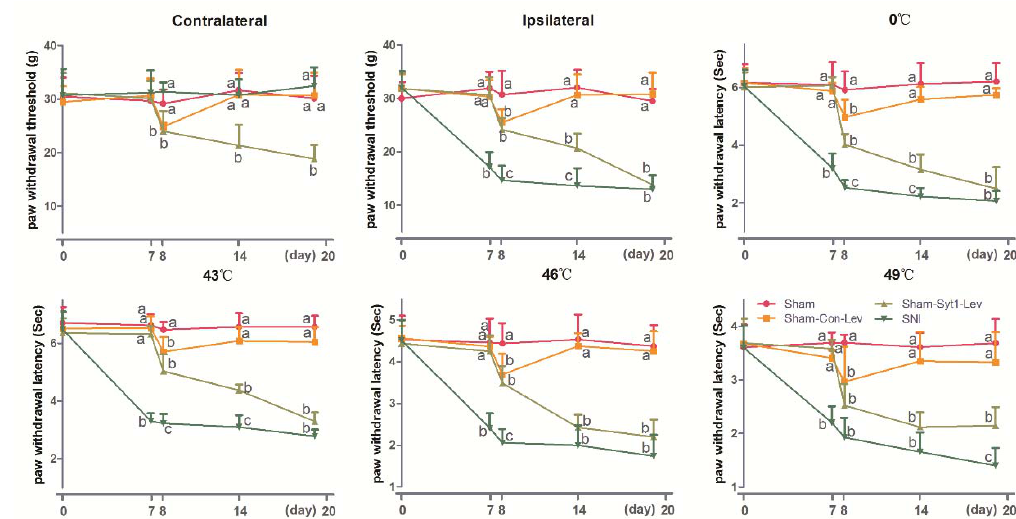
Figure 5. The e ff ect of Syt-1 lentiviral activation particles on PWTs and PWLs (Mean ± SD, n = 6). Rats in Sham-Con-Lev and Sham-Syt1-Lev groups were intrathecally injected with 15 µ L control lentiviral particles and Syt-1 lentiviral activation particles, respectively. Bilateral PWTs and PWLs (0, 43, 46 and 49 ◦ C) in Sham-Syt1-Lev rats were less than those in Sham-Con-Lev at day 14 and 20. Ipsilateral PWTs and PWLs (0, 43, and 46 ◦ C) of Sham-Syt1-Lev rats were decreased during the experiment, but not di ff erent from those of SNI rats at day 20. Values with di ff erent letters (a, b, and c) at the same day show di ff erent ( p < 0.05); two-way ANOVA followed by Bonferroni test.